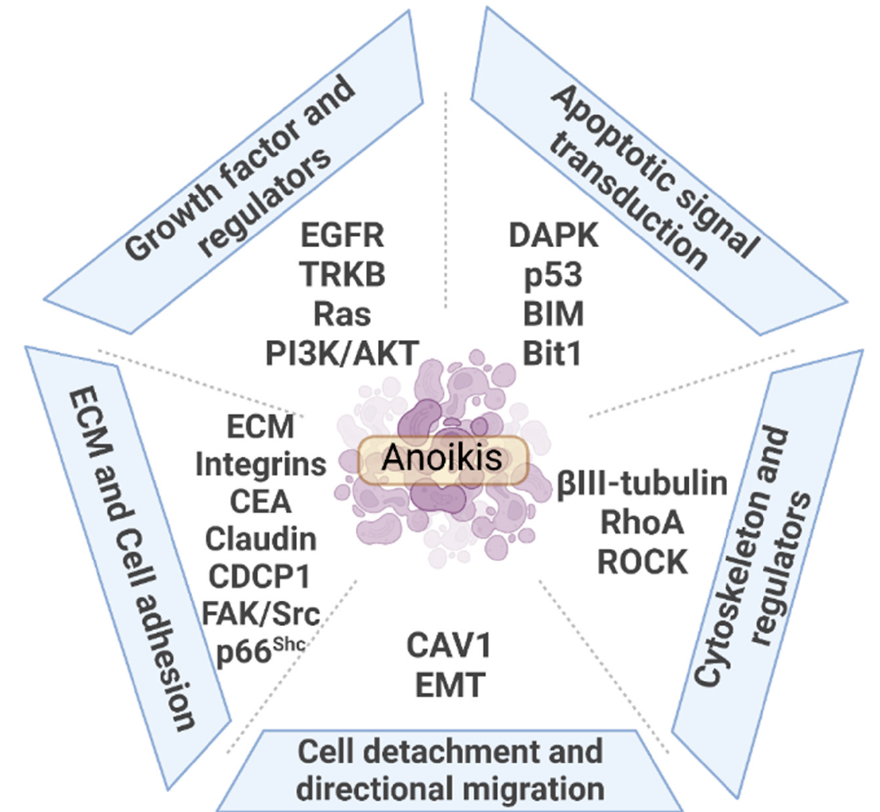
Figure 1. Overview of the regulation of anoikis in lung cancer metastasis.